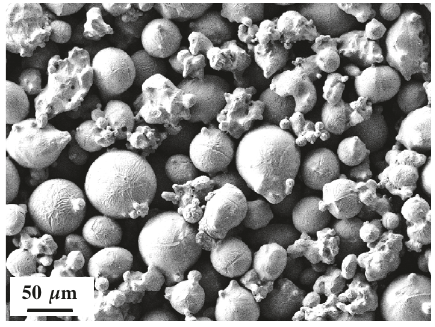
Figure 4: SEM of HTCMC sintered copper particles.